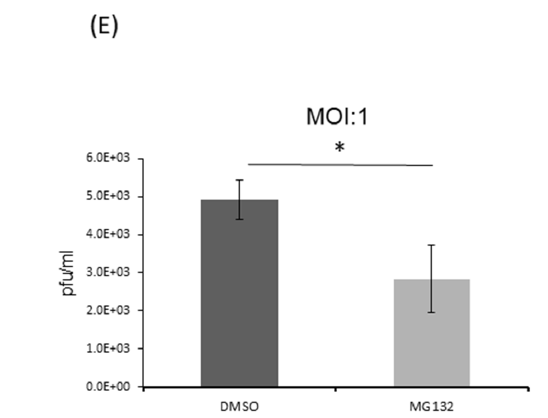
Figure 7. ( A , B ) Knockdown of PSMB4 enhanced IAV replication significantly. A549 cells transduced with sh-scramble (as the control) or sh-PSMB4 were infected with IAV (MOI = 3 or 0.01). Cell lysates were analyzed by SDS-PAGE and Western blotting against IAV M1 protein or actin ( A ) after 48 h of MOI 0.01 or 20 h of MOI = 3 infection, while secreted virions from the supernatant were quantitated by plaque assay ( B ) after 48 h of MOI 0.01 or 20 h of MOI = 3 infection. ( C , D ) Overexpression of PSMB4 suppressed IAV replication. A549 cells stably expressing GFP (as the control) or PSMB4 were infected with IAV (MOI = 0.01 or 3). Cell lysates were analyzed by SDS-PAGE and Western blotting against M1, GFP or V5 tag (for exogenous PSMB4) after 48 h of MOI 0.01 or 20 h of MOI = 3 infection ( C ), while secreted virions from the supernatant were quantitated by plaque assay after 48 h of MOI 0.01 or 20 h of MOI = 3 infection ( D ). The protein bands marked by the dotted arrow occasionally detected were probably the degraded M1 proteins. ( E ) Suppression of IAV replication by MG132. A549 cells were infected with IAV (MOI = 1) for 12 h. Then, cells were treated with 10 uM MG132 or not. Secreted virions from the supernatant were quantitated by plaque assay after another 12 h. * p < 0.05, ** p < 0.01, *** p < 0.001